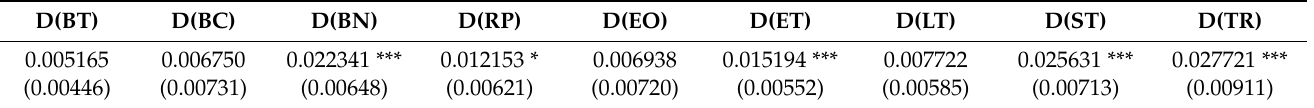
Table 6. Impact of Pandemic (DP) in the Short